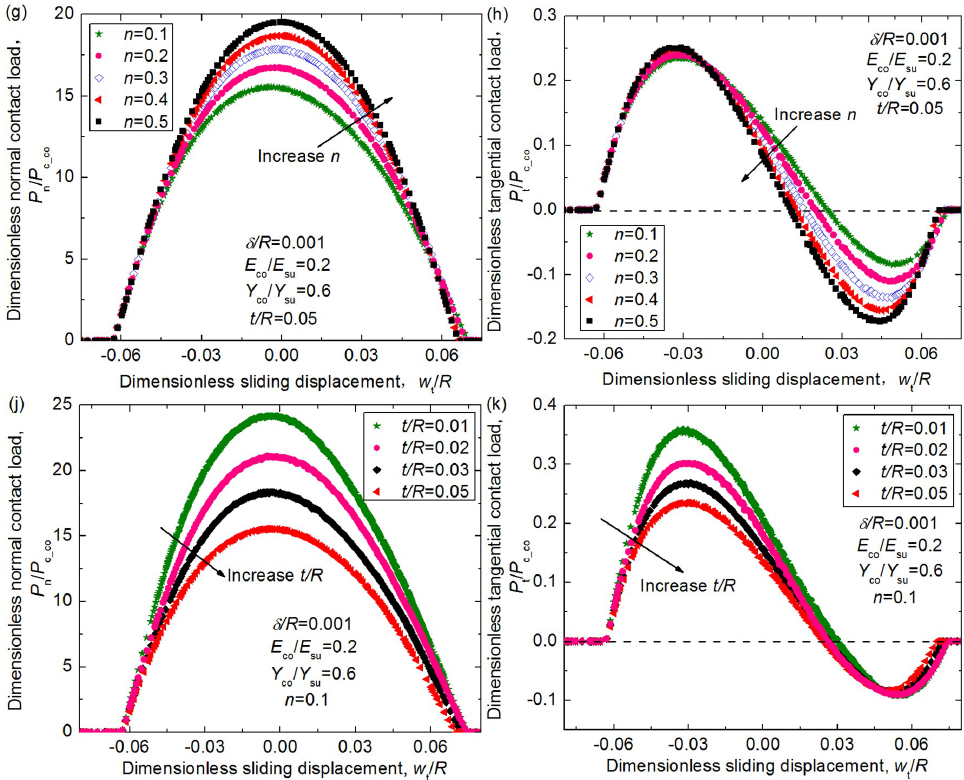
Figure 5. The relation of the dimensionless normal and tangential load, P n / P c_co , P t / P c_co , and the dimensionless interference, w t / R , under different normal interferences, δ/R , for different cases where Young’s modulus ratios, E co / E su , yield strength ratios, Y co / Y su , hardening exponent, n , and thickness, t/R , of the coating change in specific ranges. ( a ) The effect of δ/R on P n / P c_co ; ( b ) The effect of δ/R on P t / P c_co ; ( c ) The effect of E co / E su on P n / P c_co ; ( d ) The effect of E co / E su on P t / P c_co ; ( e ) The effect of Y co / Y su on P n / P c_co ; ( f ) The e ff ect of Y co / Y su on P t / P c_co ; ( g ) The e ff ect of n on P n / P c_co ; ( h ) The e ff ect of n on P t / P c_co ; ( j ) The e ff ect of t / R on P n / P c_co ; ( k ) The e ff ect of t / R on P t / P c_co